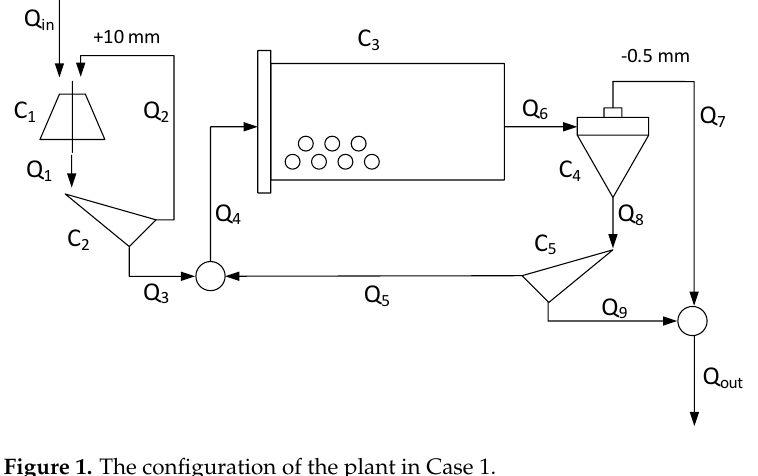
Figure 1. The configuration of the plant in Case 1.